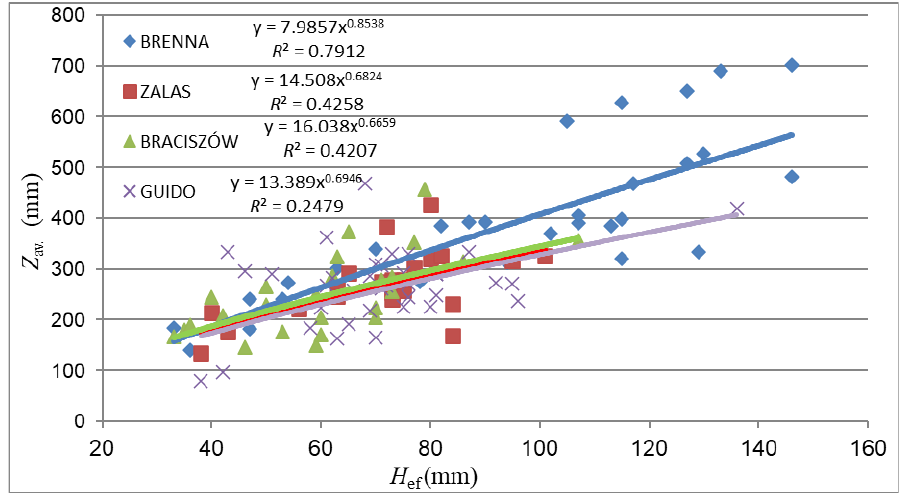
in relation to the effective anchoring depth H av.